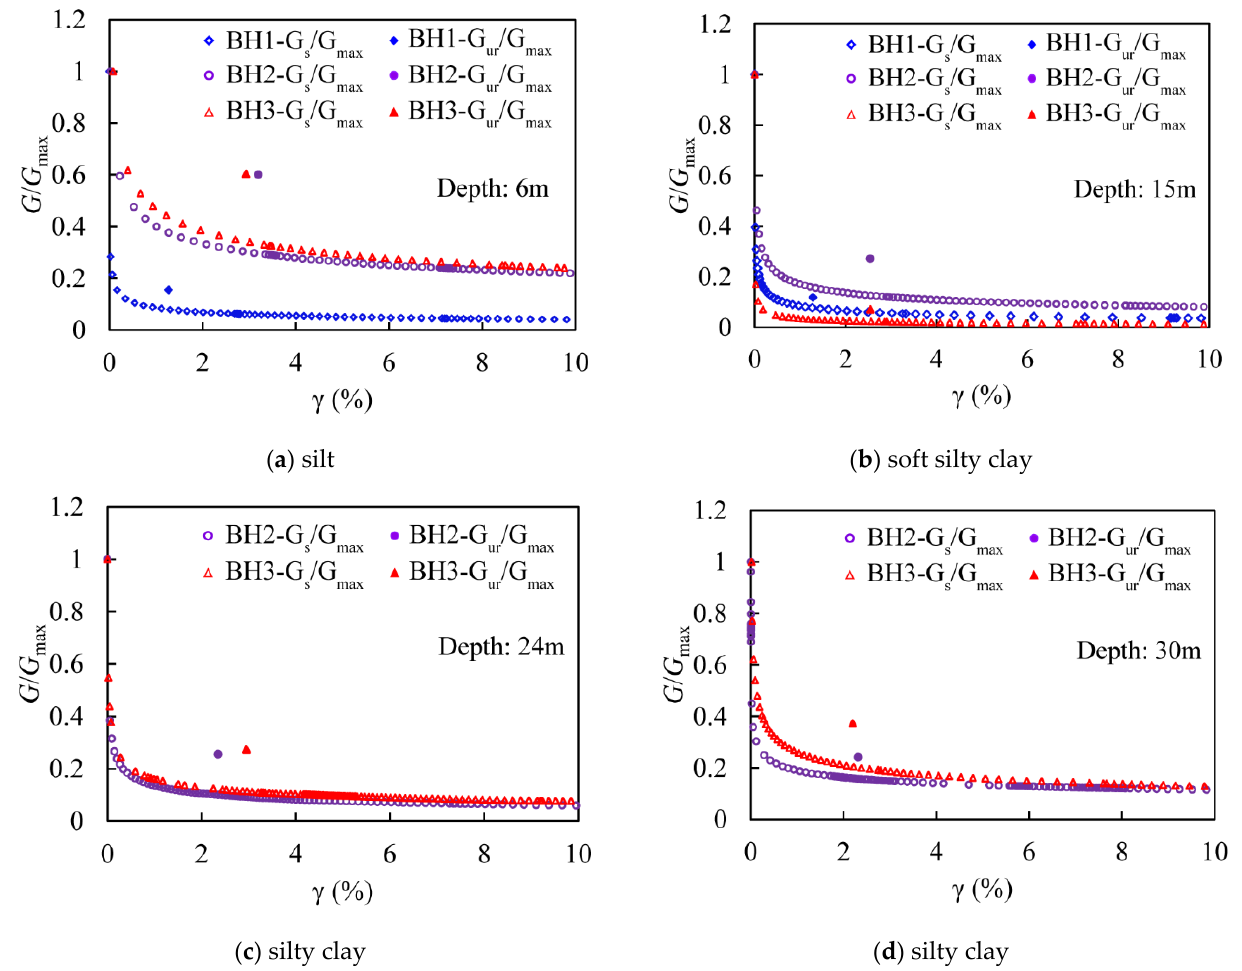
Figure 11. Normalized shear modulus of different soil types and depths.